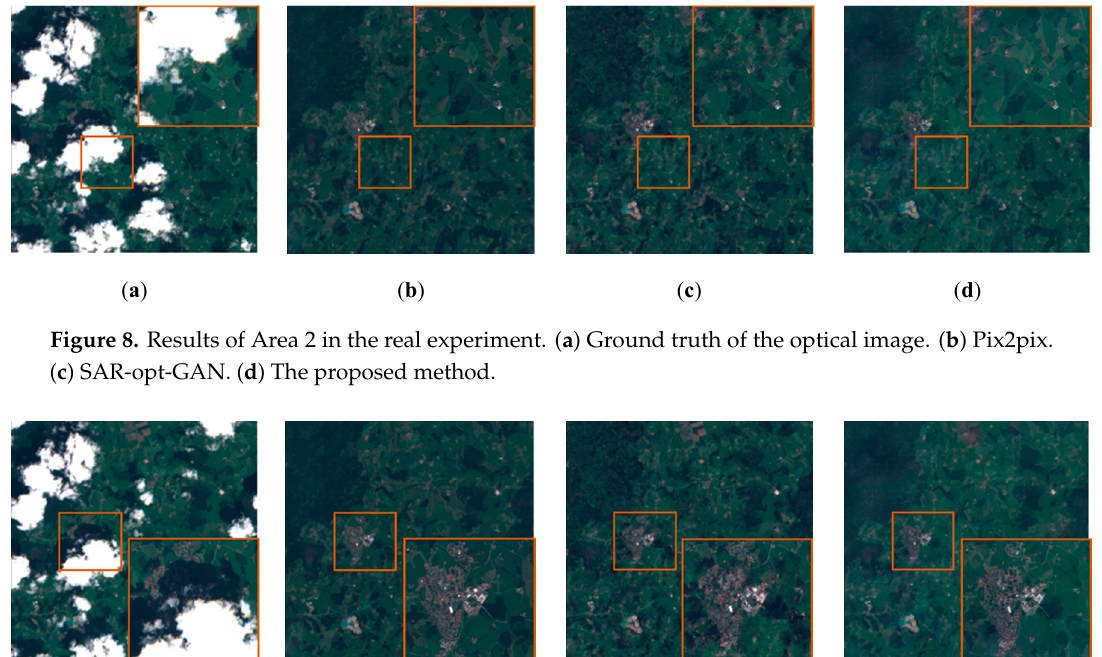
Pix2pix. ( c ) SAR-opt-GAN. ( d ) The proposed method.